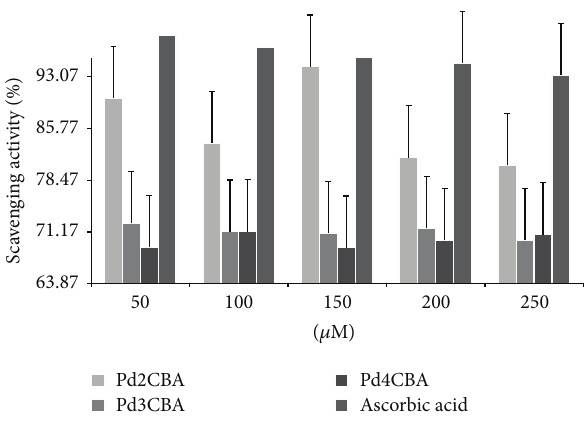
Figure 8: Free radical-scavenging activities of synthesized